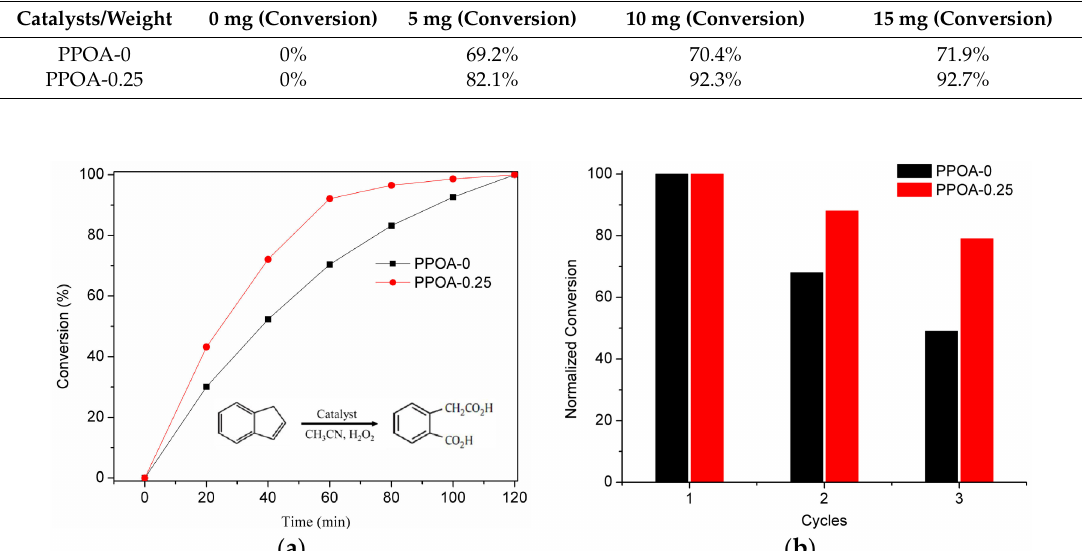
Figure 5. Time-variable conversion of indene by PPOA-0 and PPOA-0.25 ( a ). Comparison of the conversion for PPOA-0 and PPOA-0.25 over three reaction runs. The reaction time is 120 min ( b ). The weight of catalysts is 10